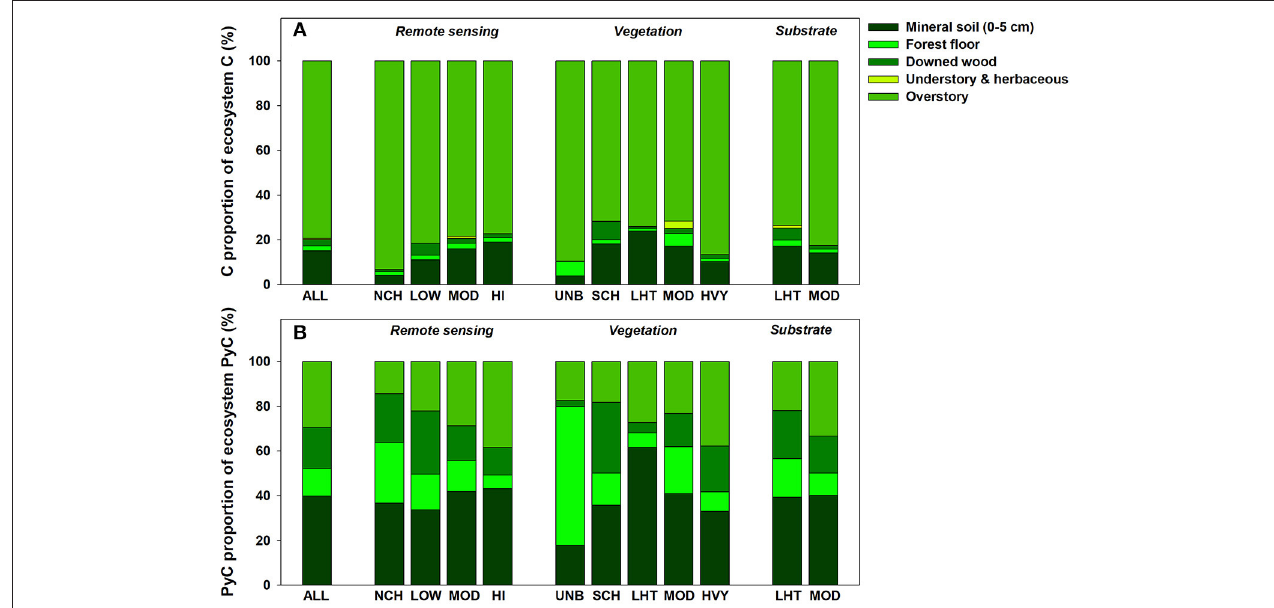
FIGURE 6 | (A) Proportions of total measured ecosystem C stocks contributed by C stocks in each forest component; (B) proportions of total measured ecosystem PyC stocks contributed by PyC stocks in each forest component (for PyC estimated as PyC CTR via chemical oxidation), in post-fire mixed-conifer forest, shown by fire severity levels classified using remote sensing and field observation (vegetation, substrate) approaches. Total ecosystem PyC and C stocks included the 0–5cm mineral soil depth increment to the tree layer, to represent the pool of C most directly exposed to fire or heating during fire. Severity abbreviations follow those given in Figure 3